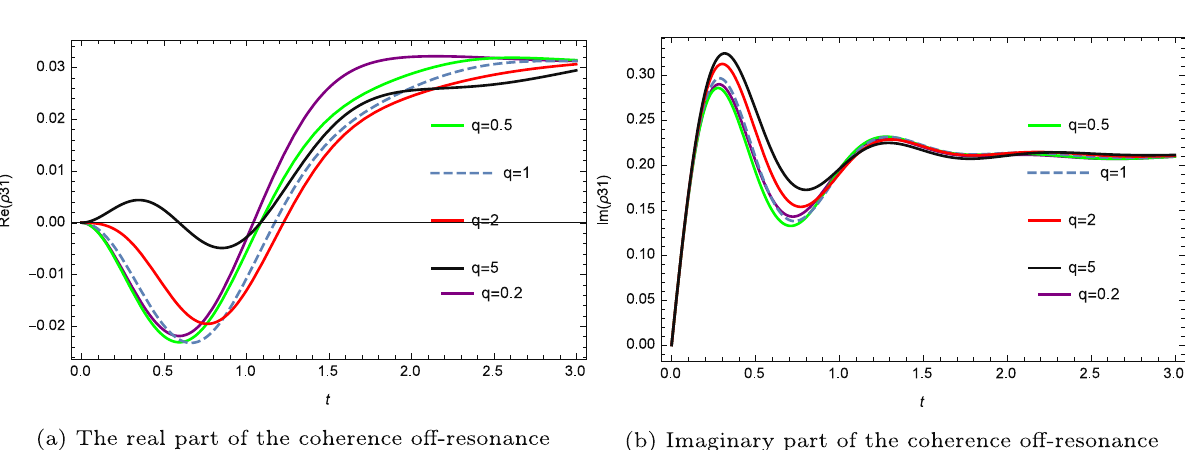
Figure 3. Rb 87 in a three level configuration controlled by various q-deformed waveforms: the atomic population inversion and the coherence in terms of time t scaled to the pulse rise time.